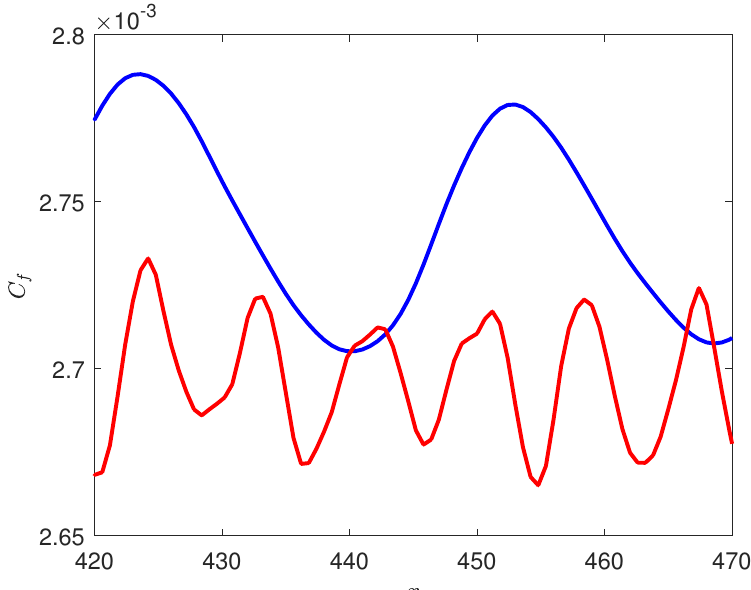
Figure 9. Skin friction coefficient for the travelling wave forcing (TW) (one phase is shown in red) together with skin friction coefficient for the pure spatial forcing (SW)